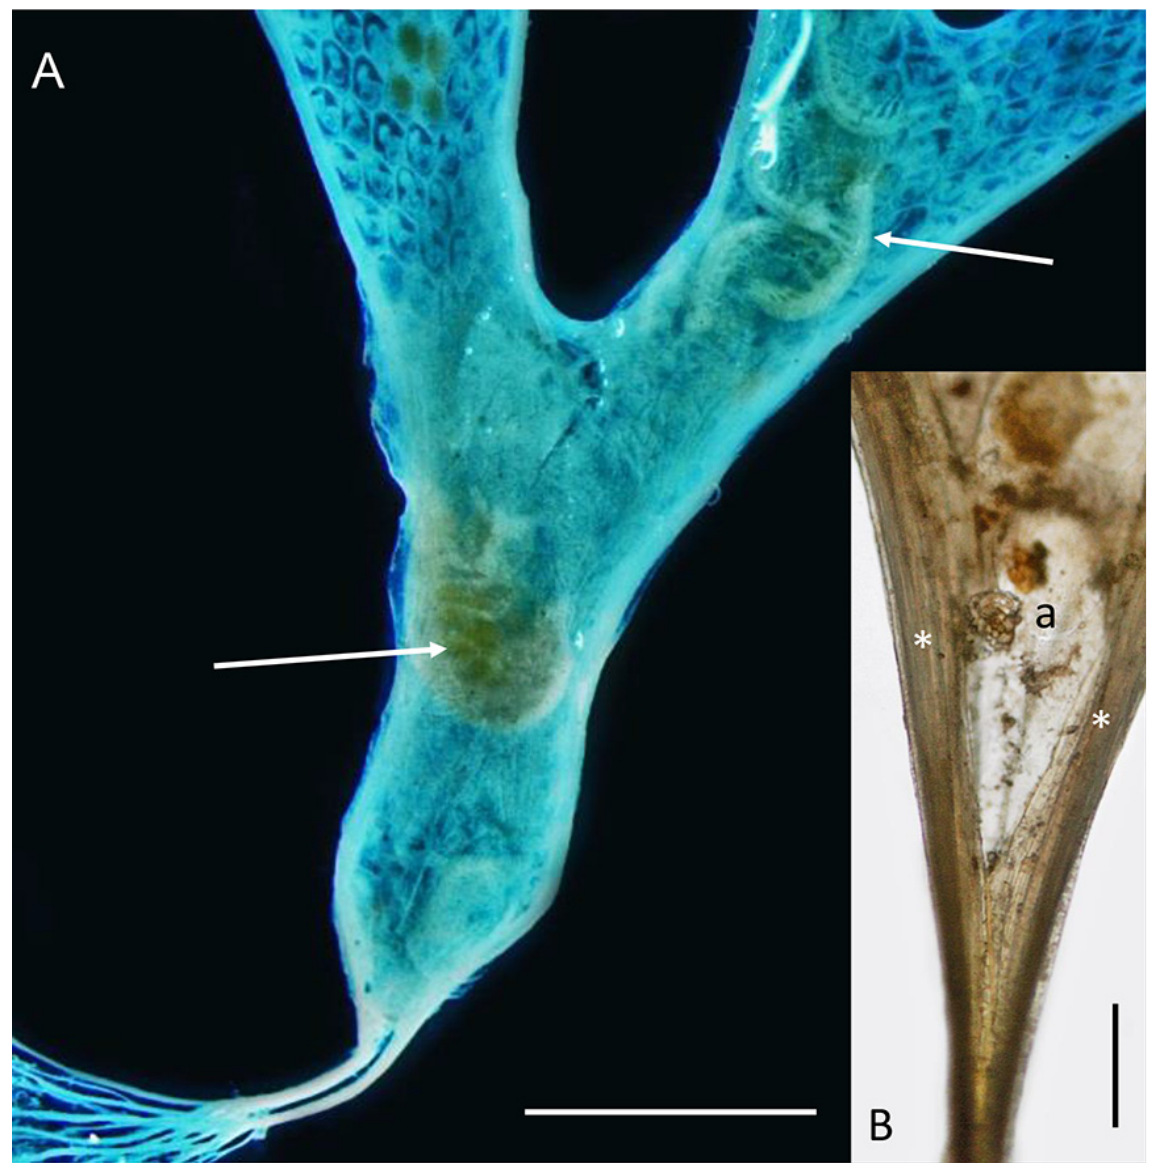
Fig. 2. A . Photograph of the abfrontal side of a colony of the bryozoan Onchoporoides moseleyi showing adults (middle left arrow) and juveniles (upper right arrow) of Bryoconversor tutus gen. et sp. nov. beneath the semitransparent abfrontal membrane. Note the paired kenozooidal rootlets and their branches at lower left; these anchor the colony to sediment grains in the soft-sediment habitat. The blue colour of the colony is optical, not staining. B . Optical photograph of the proximal end of a small colony of Onchoporoides moseleyi showing the ancestrular zooid (a) in abfrontal view, with calcified interiors (*) of lateral kenozooids that converge proximally. Scale bars: A = 3 mm; B = 100